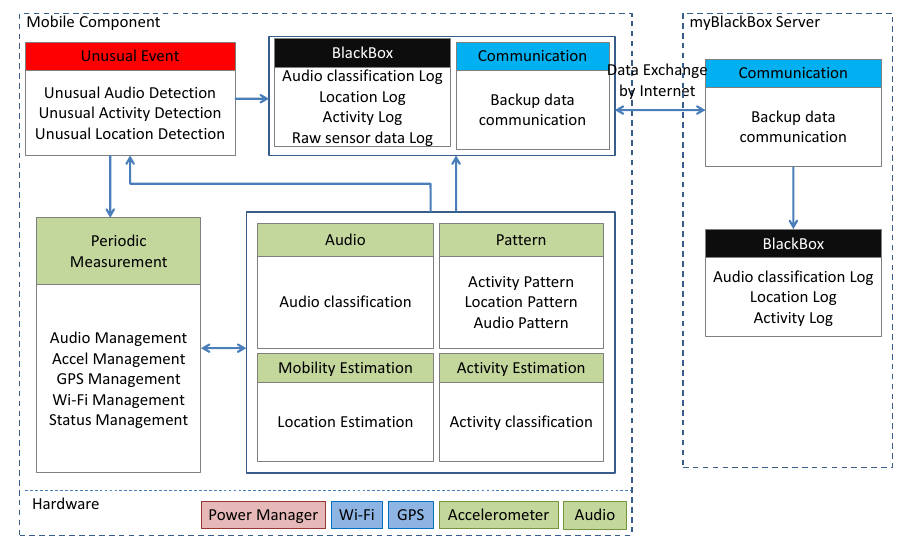
Figure 4. Architectures of the myBlackBox mobile component and the myBlackBox cloud